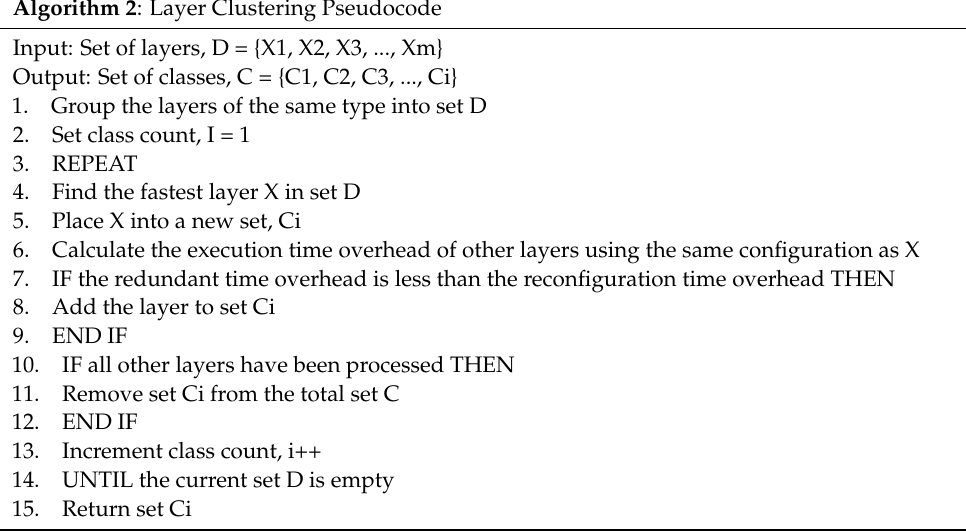
Algorithm 2 : Layer Clustering